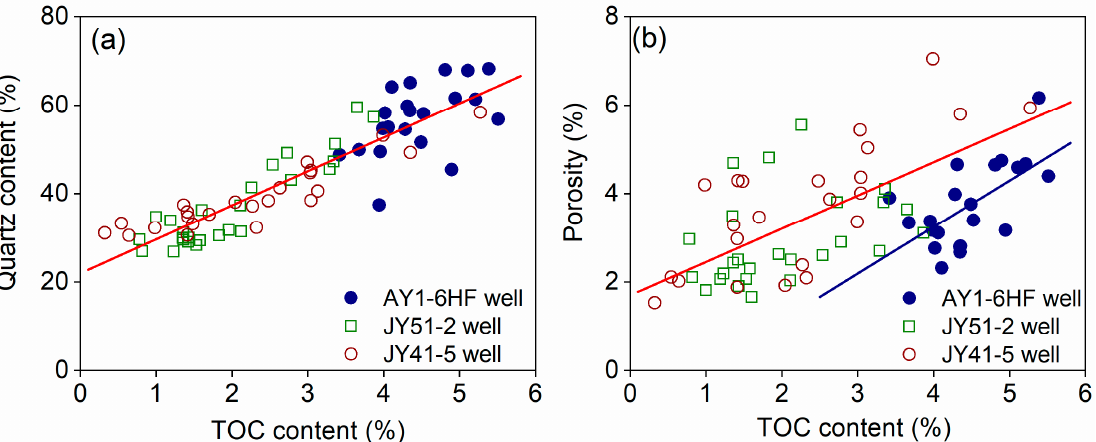
Figure 8. The correlation between TOC content and the ( a ) quartz content and ( b ) porosity of Wufeng–Longmaxi shales at the Anchang Syncline (data from JY41-5 and JY51-2 wells are collected from [30,31]).